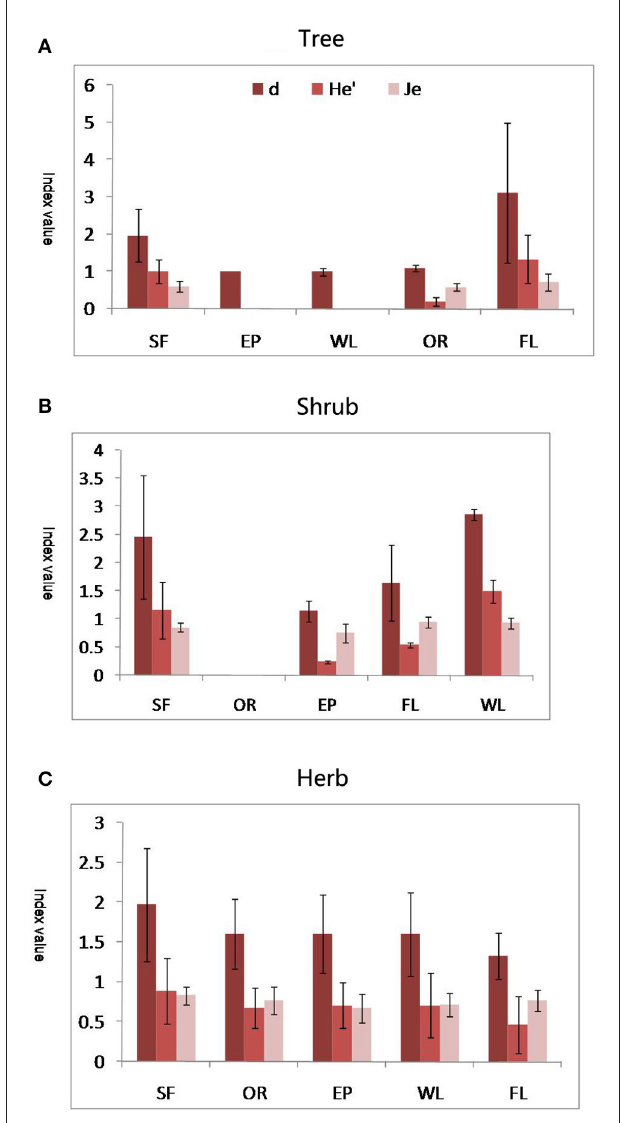
FIGURE 4 | The plant diversity d, He ′ , and Je in tree (A) , shrub (B) , and herb (C) layer. SF, Secondary evergreen needle- and broad-leaves mixed forest; FL, Farmland; EP, Eucaluptus plantation; OR, Orchard; WL,